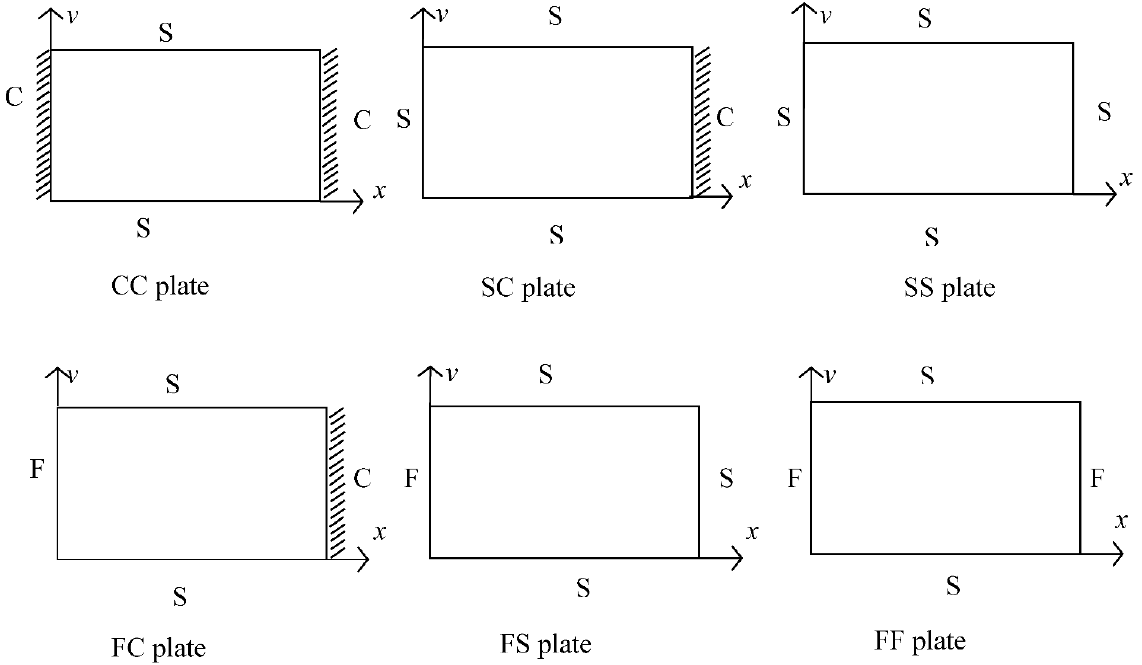
Figure 2. Levy-type solution boundary conditions of the orthotropic plate.